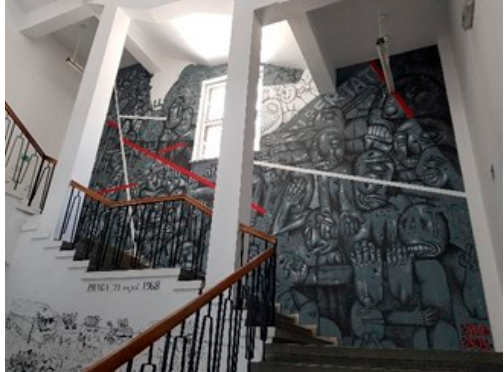
Figure 39. “Revolution from 1989”, University of Bucharest by Pisica P ă trat ă , 2020 (photo taken in 2022).